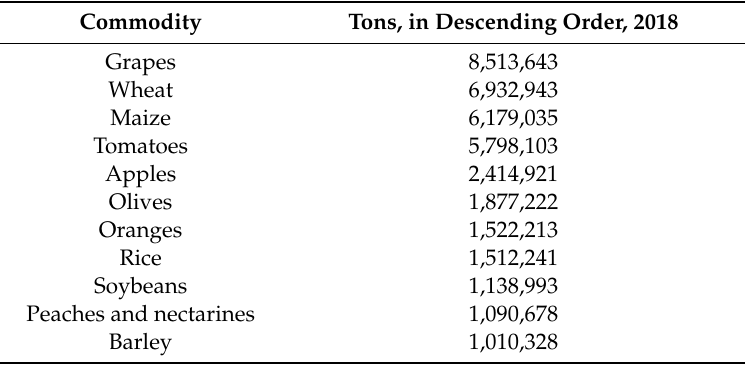
Table 6. Italy’s Agricultural Commodity Production Tons, in